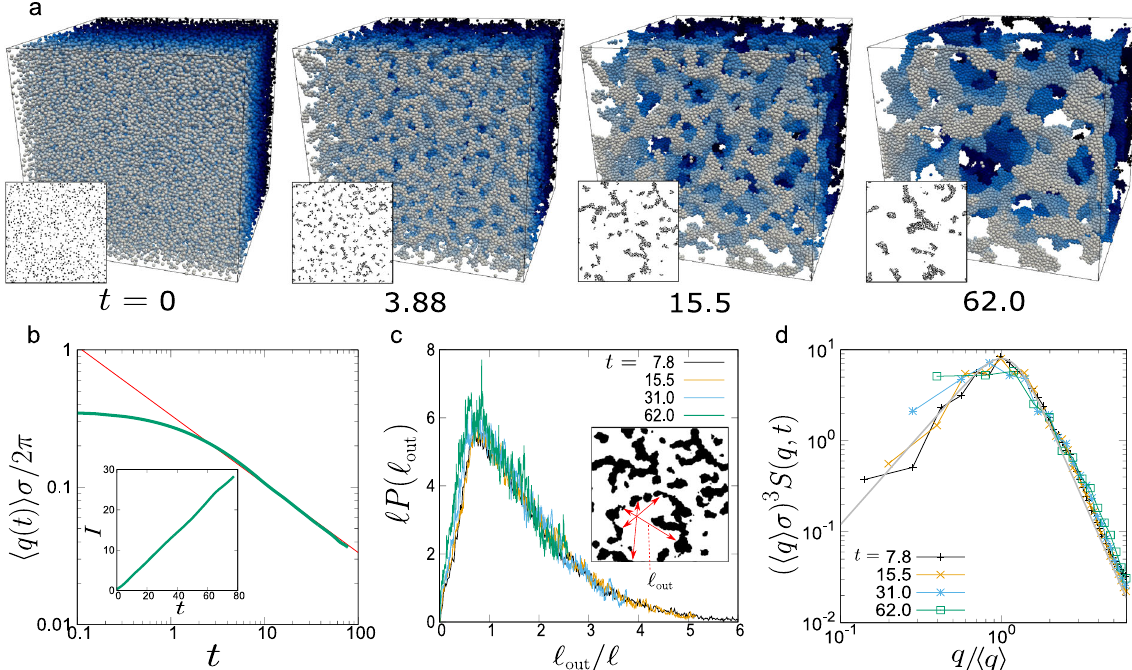
Fig. 3 Coarsening behaviour of network-forming phase separation of a colloidal suspension. a Time evolution of 3D phase-separation structure (see Supplementary Movie). Particles are coloured to distinguish front particles from back ones. Here we also show the cross-section image of each structure in black&white colour. b Temporal change of the characteristic wavenumber 〈 q 〉 . The red line represents a power-law function of the exponent − 1/2. The inset shows the temporal change of the integrated intensity I ( t ) of the structure factor S ( q , t ). We can see that I ( t ) ∝ t . c The chord length distribution functions for the colloid-poor phase, P ( ℓ out ), at various times, after scaling the length by the characteristic length ℓ = 2 π / 〈 q 〉 . ℓ out is determine by measuring the length of the lines extending radially from randomly chosen points within the colloid-poor region (see the red arrows in the inset). d Scaled structure factors, ( 〈 q 〉 σ ) d S ( q , t ) ( d : spatial dimension; d = 3), as a function of q / 〈 q 〉 for various times. The grey curve is the fi t by the so-called Furukawa x = q / 〈 q 〉 , κ = d + 1, and A is a function 37 , Ax 2 κ þ x 2 þ κ , where 2